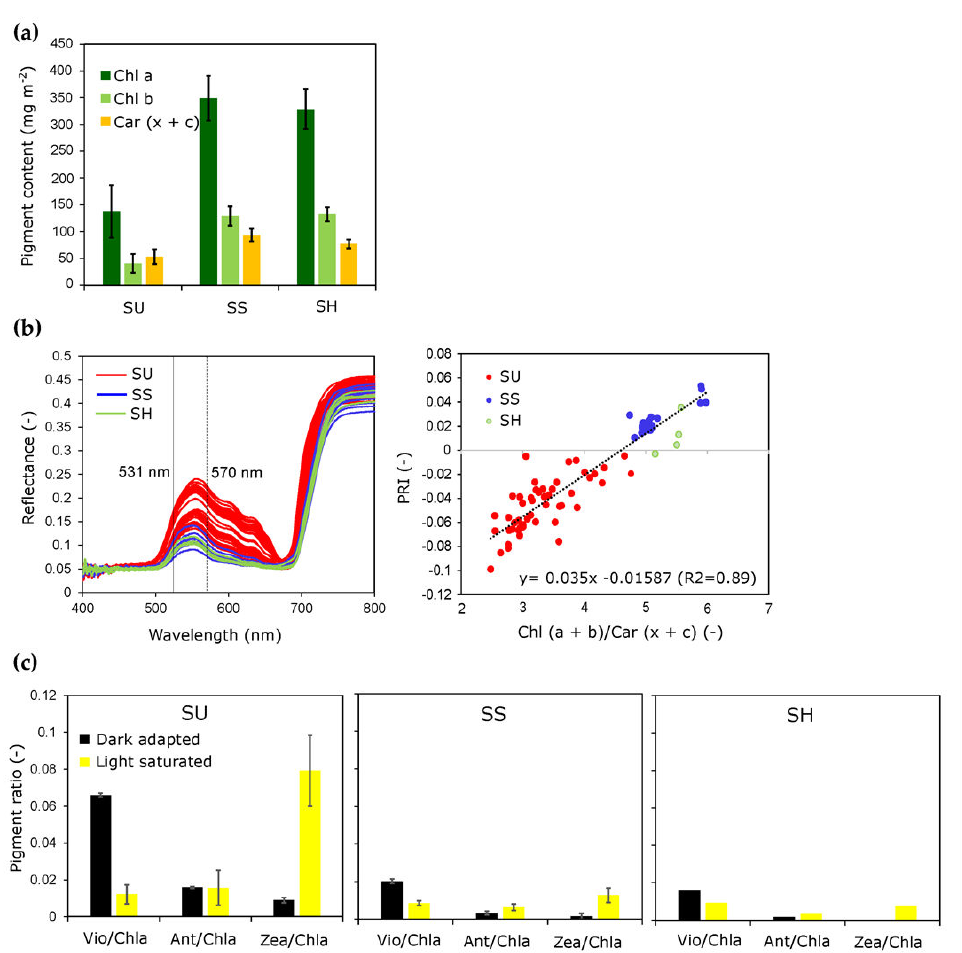
Figure 9. ( a ) Leaf contents of chlorophyll a, b and carotenoids for sun-adapted (SU, n = 48), in- termediately sun-shaded adapted (SS, n = 24) and shade-adapted (SH, n = 4) beech saplings; ( b ) reflectance measured in the integrating sphere (R Leaf-S ) for the sets of SU, SS and SH leaves (left), and the relationship between the PRI and the Chl / Car ratio (right); ( c ) dark and saturating light-adapted pools of the xanthophyll pigments (violaxanthin, antheraxanthin and zeaxanthin) normalized to the Chl a pool for SU, SS and SH